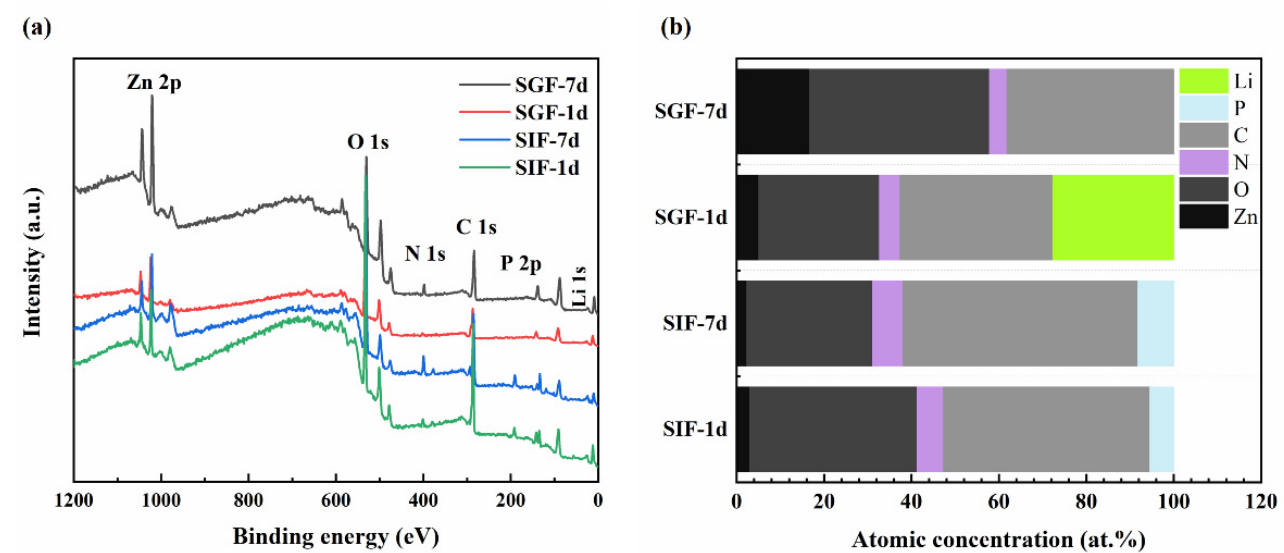
Figure 4. Immersion in SGF and SIF for 1 and 7 days: ( a ) XPS spectra; ( b ) atomic concentration of elements detected by XPS.